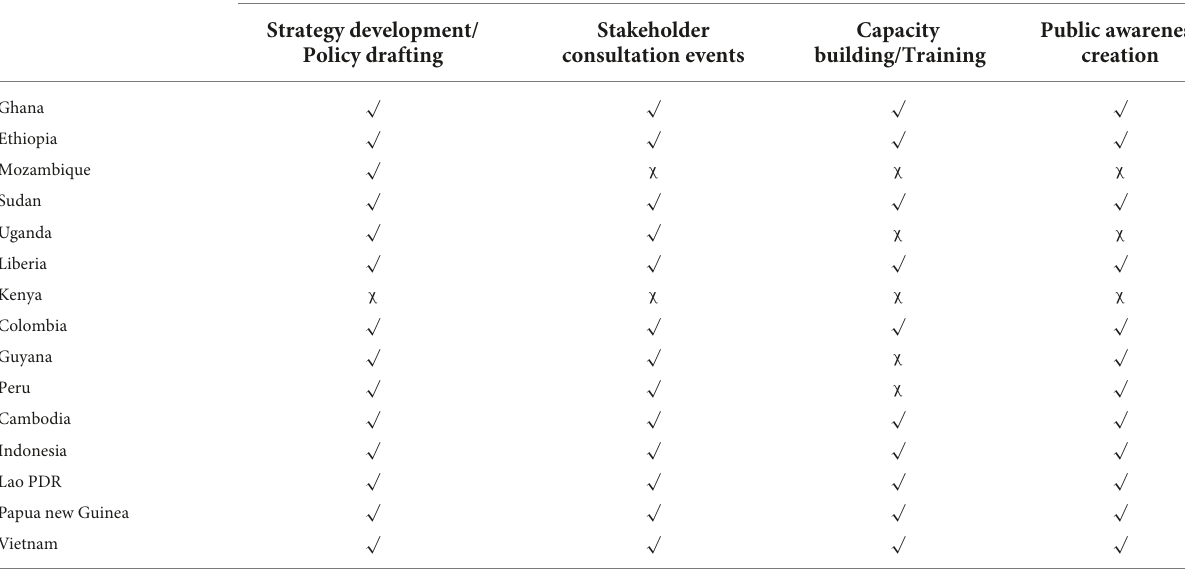
TABLE 3 REDD+ readiness related-activities carried out by each participant